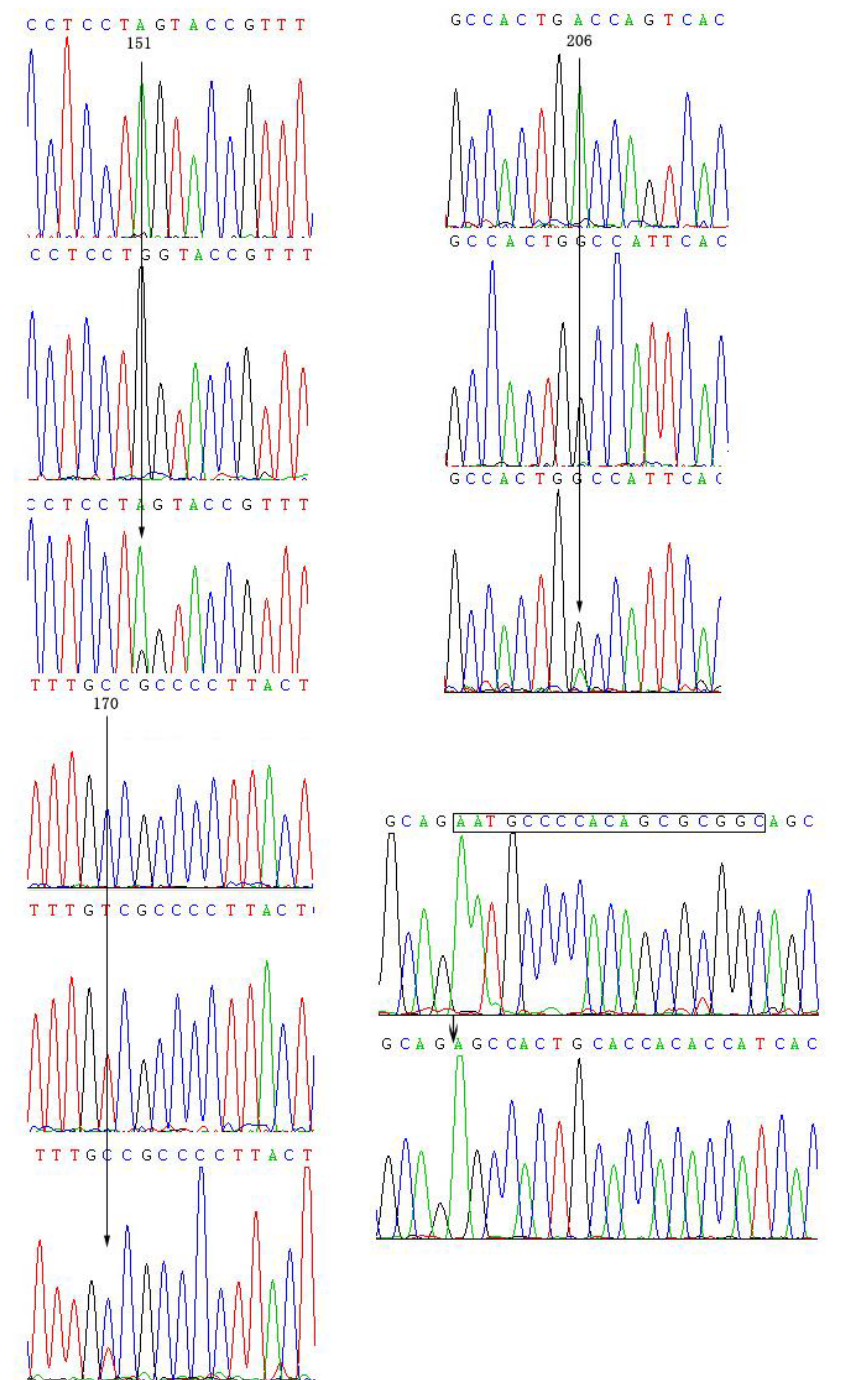
Figure 1. DNA sequencing maps from several DNA templates at four SNPs of duck VLDLR .